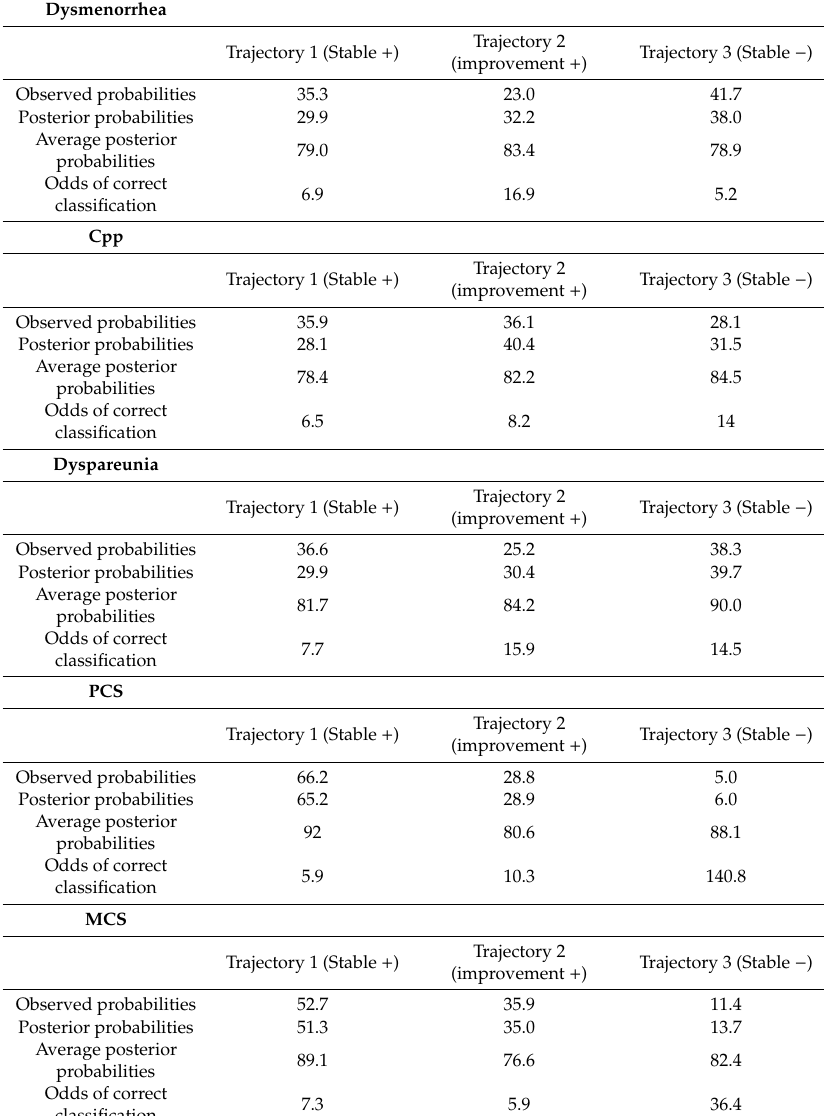
Table 2. Characteristics of pelvic pain and quality-of-life